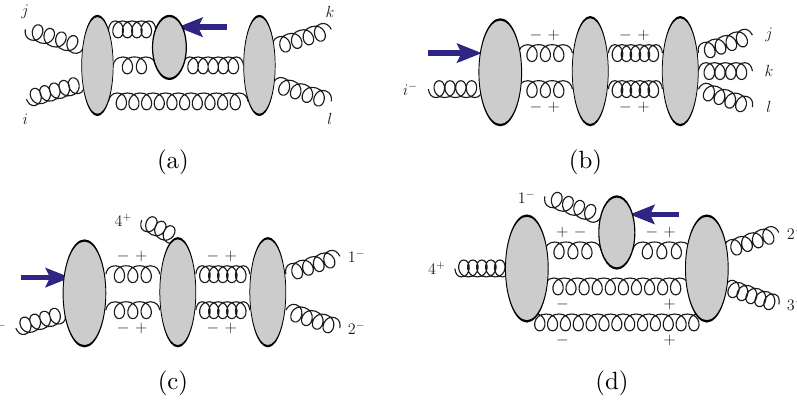
Figure 14. The unitarity cuts which are same for general gauge